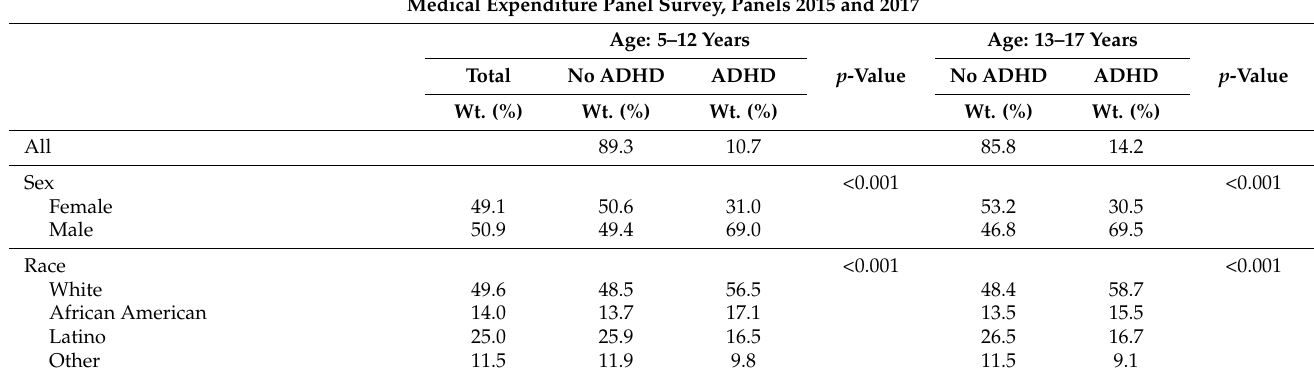
Table 1. Characteristics of the study sample by age and the presence of Attention-deficit/hyperactivity disorder (N =